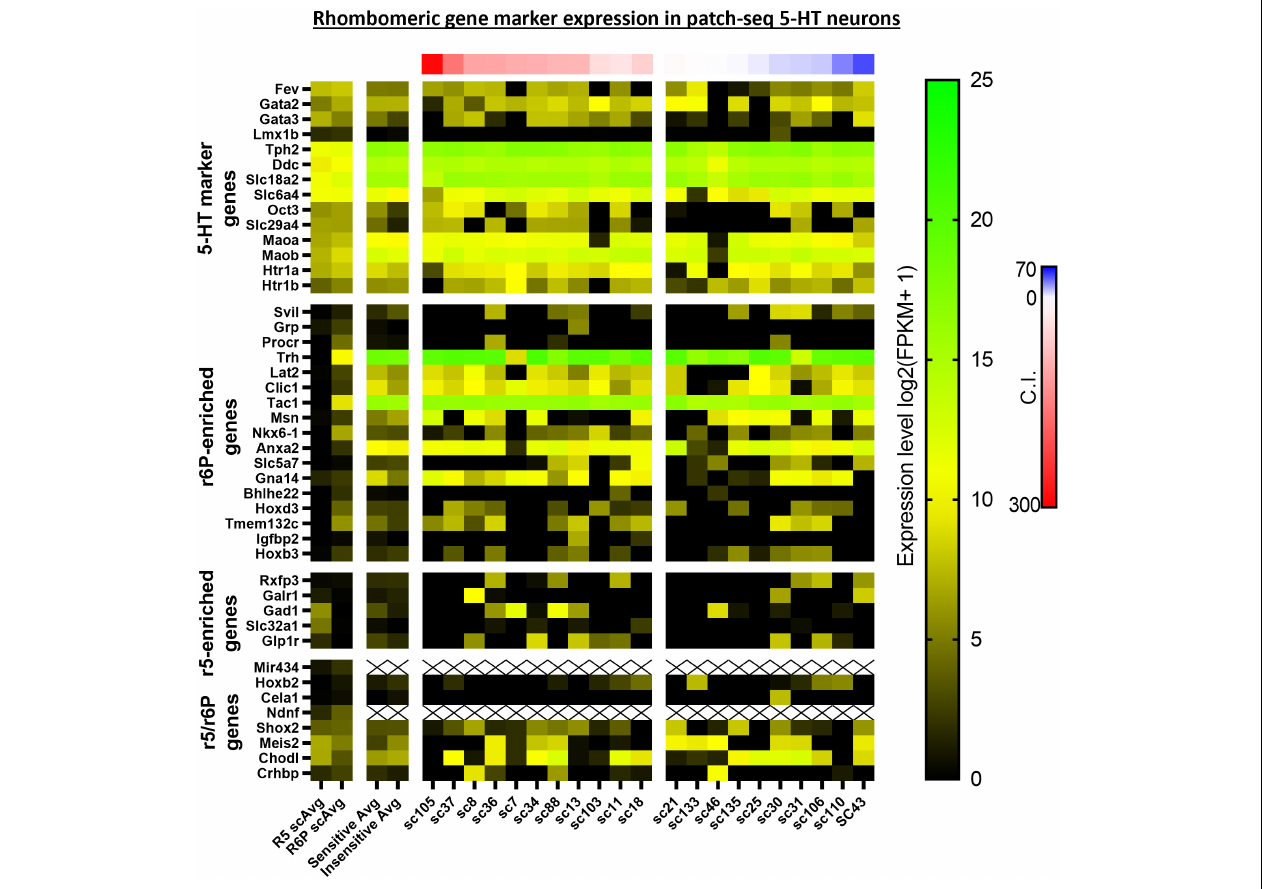
FIGURE 6 | Heatmap of averaged single cell RNA Seq gene expression data derived from rhombomeric 5 (r5; i.e., CO 2 sensitive 5-HT mouse neurons) and 6 (r6; i.e., CO 2 insensitive 5-HT mouse neurons) in mice from a prior study by Okaty et al. (2015) compared to both averaged and single cell data of our 5-HT CO 2 sensitive and insensitive rat neurons indicate differences in transcriptomic regulation of chemosensitivity between species. 5-HT marker genes (top horizontal panel) are enriched in both data sets. R6p-enriched genes (top middle horizontal panel) are highly expressed across all rat 5-HT neurons regardless of chemosensitivity while r5-enriched genes (lower middle horizontal panel) are undifferentiated between rat CO 2 sensitive and insensitive 5-HT neurons. r5/r6p genes (bottom horizontal panel) are similarly expressed between CO 2 sensitive and insensitive 5-HT rat neurons, consistent with the expression differences between R5 and R6p